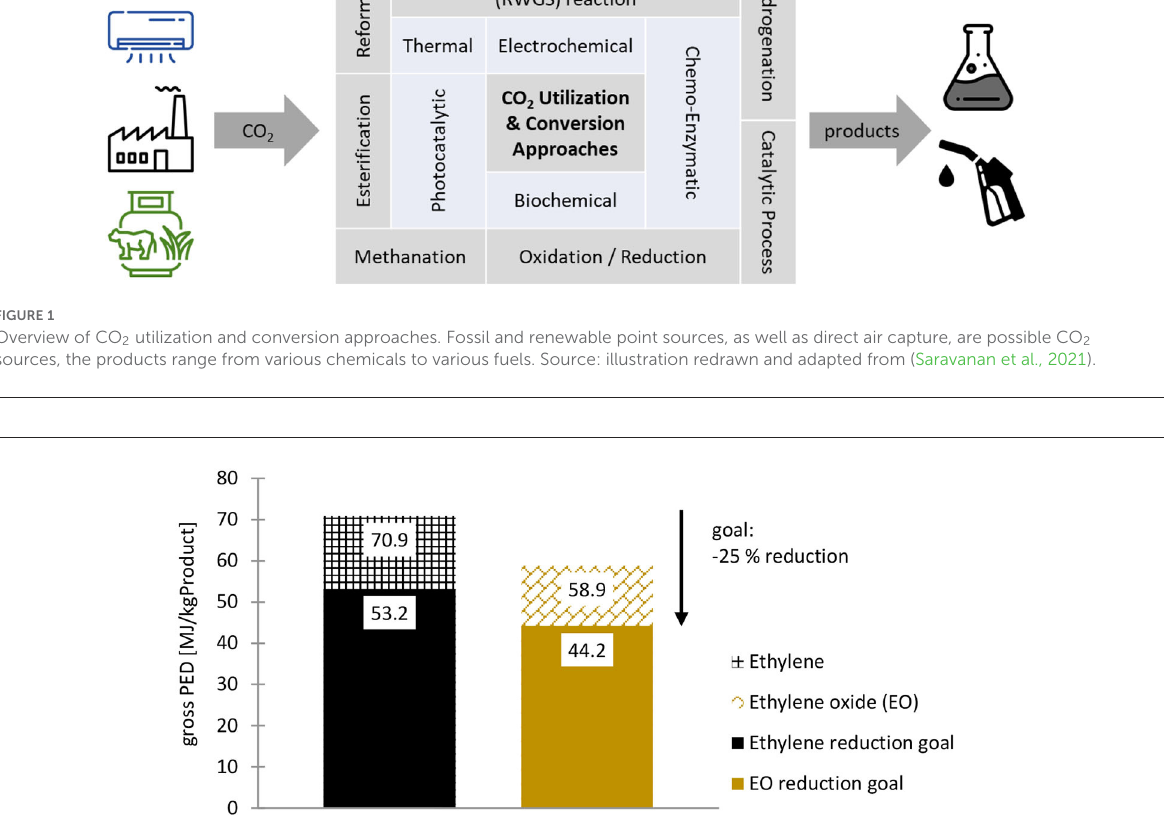
oxidation from ethylene to CO 2 , increase the carbon footprint of EO (Mobley et al.,